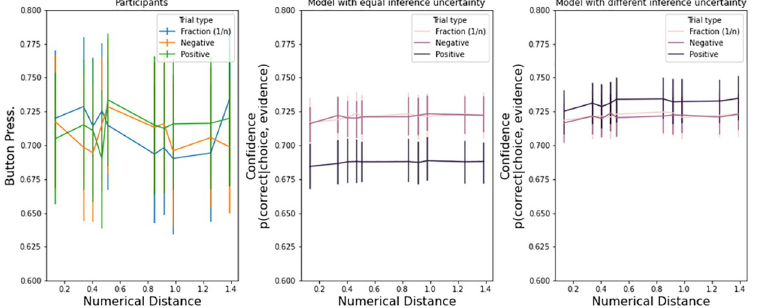
Fig 9. Reduced uncertainty in trials with positive numerals. Exp. 2: models with equal uncertainty had an UN = 4.5 for all types of numerals. Models with different uncertainty had UN pos = 3.5, UN neg = 4.3, UN frac =